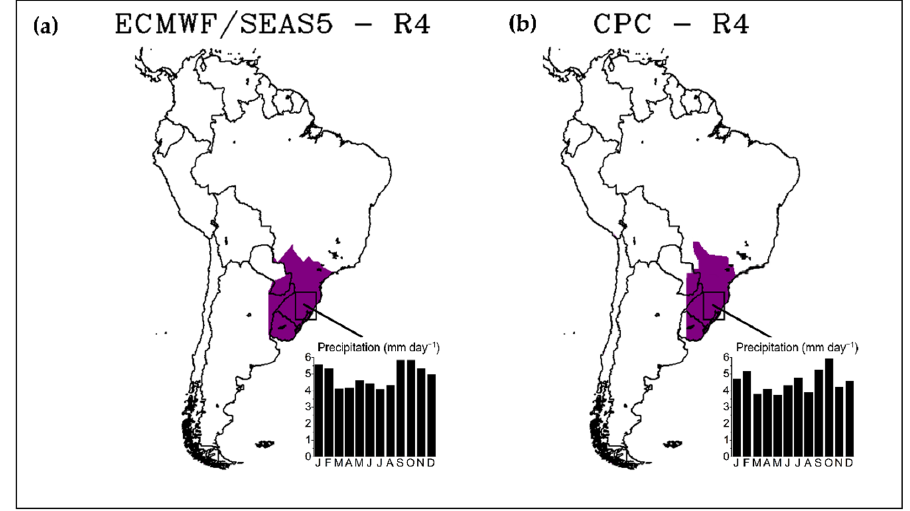
Figure 9. Similar to Figure 6, except for Region 4